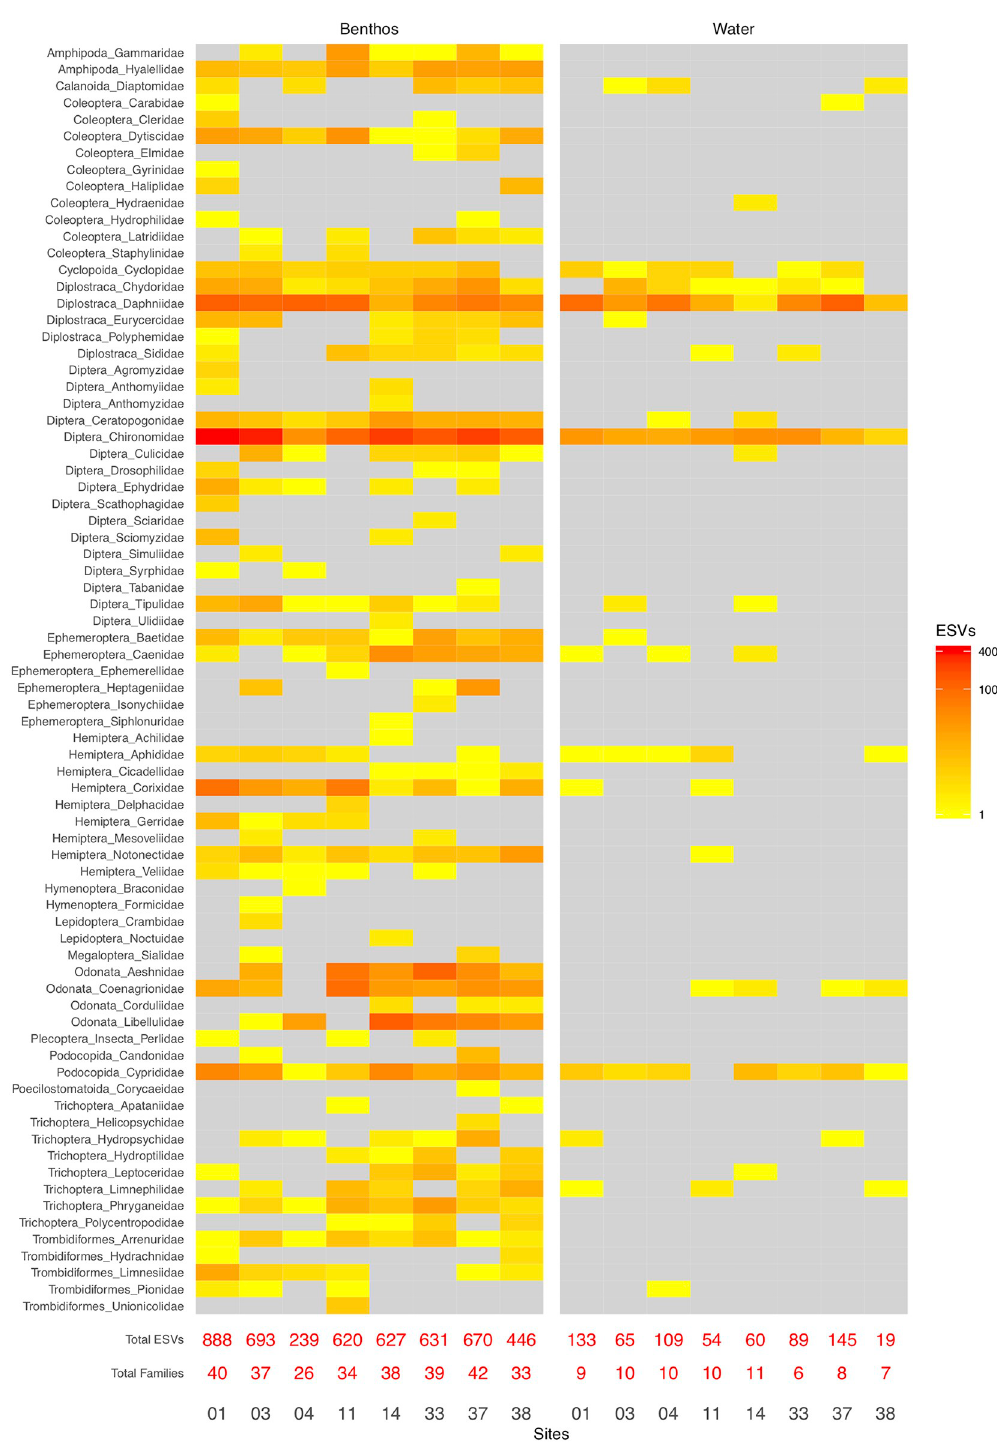
Fig 5. More Ephemeroptera, Plecoptera, Trichoptera, and Odonata family ESVs are detected from benthos compared with water samples. Each cell shows ESV richness colored according to the legend. Grey cells indicate zero ESVs. Only ESVs taxonomically assigned to families with high confidence (bootstrap support > = 0.20) are included. Based on normalized data.